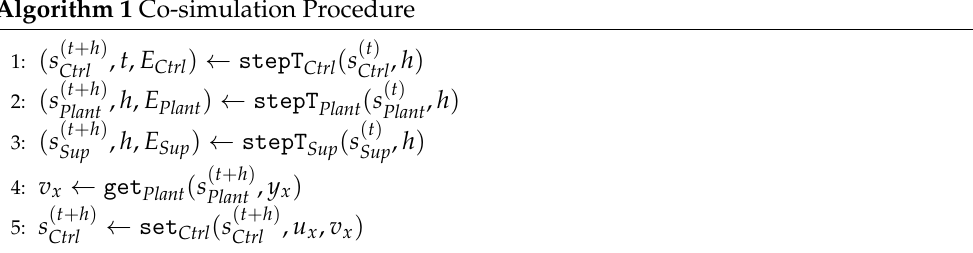
Algorithm 1 Co-simulation